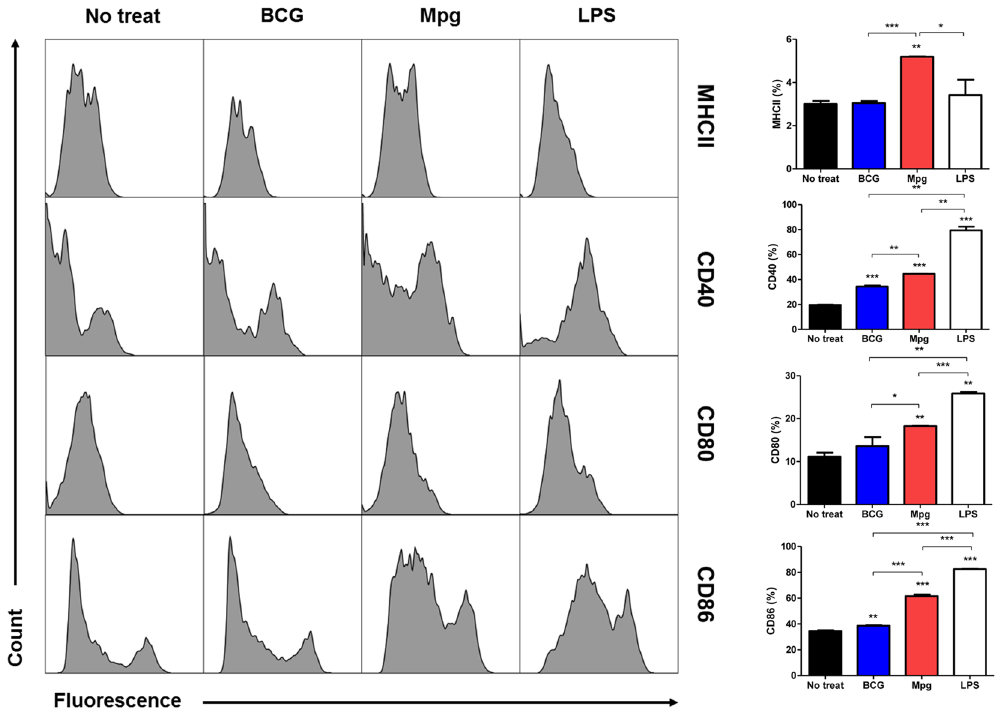
Figure 2. M. paragordonae (Mpg) induced enhanced BMDC maturation. BMDCs were infected with BCG, Mpg (10 M.O.I.) or LPS (1 μ g/ml) overnight, stained with antibodies against DC maturation surface markers (CD40, CD80, CD86 and MHC II), and then analyzed by flow cytometer. Representative histograms of CD11c- gated cells are presented, and the mean fluorescent intensity (MFI) of each BMDC maturation surface marker are shown in the graph ( * P < 0.05, ** P < 0.01, *** P < 0.001; Student’s t